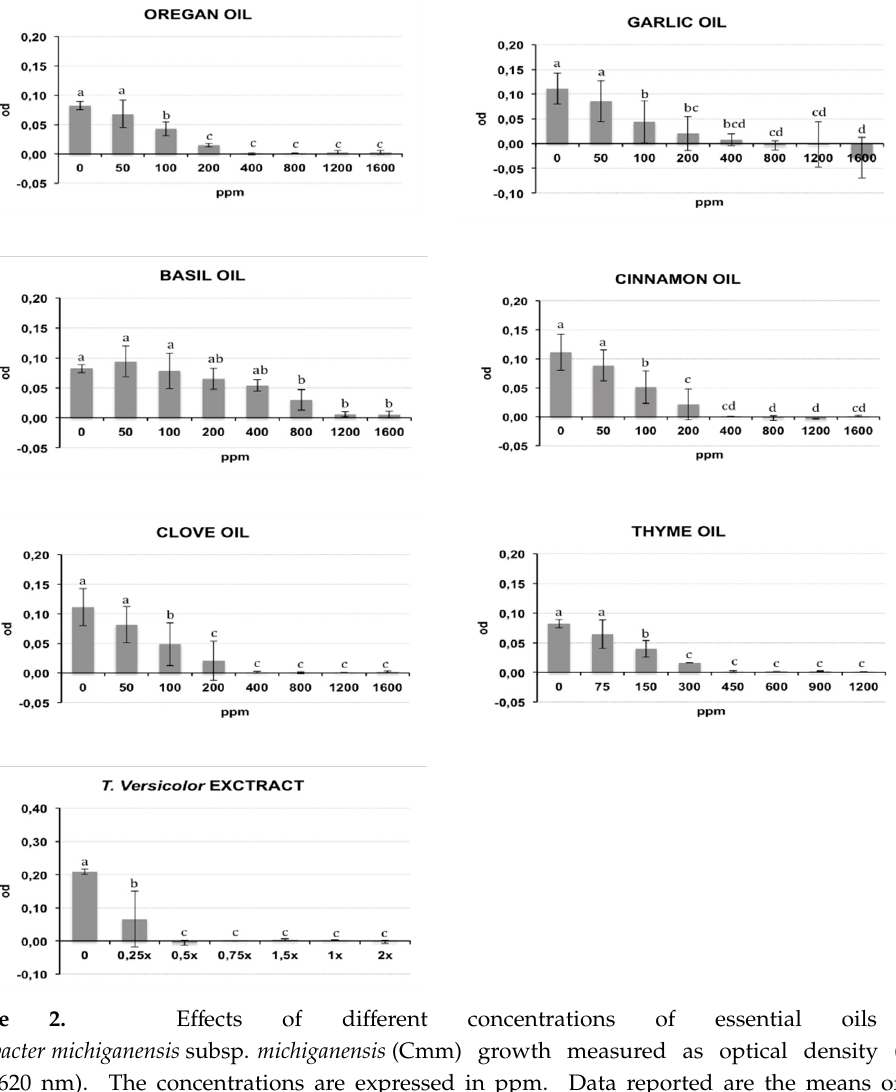
Figure 2. E ff ects of di ff erent concentrations of essential oils on Figure 2. Effects of different concentrations of essential oils on Cla v ibacter michiganensis subsp. Clavibacter michiganensis subsp. michiganensis (Cmm) growth measured as optical density (OD) michiganensis (Cmm) growth measured as optical density (OD) ( λ = 620 nm). The concentrations are ( λ = 620 nm). The concentrations are expressed in ppm. Data reported are the means of the expressed in ppm. Data reported are the means of the two repetitions of the experiment. The error two repetitions of the experiment. The error bar shows the standard deviation. Significant di ff erences bar shows the standard deviation. Significant differences ( p ≤ 0.01) found using the Tukey-Kramer ( p ≤ 0.01) found using the Tukey-Kramer test for multiple comparison are indicated as letters a–f: test for multiple comparison are indicated as letters a–f: the same letter within the same graph means the same letter within the same graph means no statistical significance between the no statistical significance between the treatments.